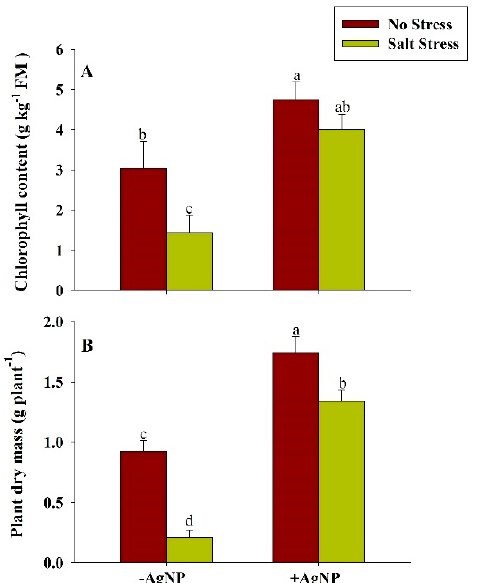
Figure 6. Estimation of ( A ) Chlorophyll content and ( B ) plant dry mass content in wheat at 30 DAS. Plants were grown individually with 0 (control), 100 mM NaCl, 300 ppm AgNPs and NaCl combined with AgNPs. Data are presented as treatments mean ± SE (n = 3). Data followed by the same letter are not significantly di ff erent by LSD test at ( p < 0.05).